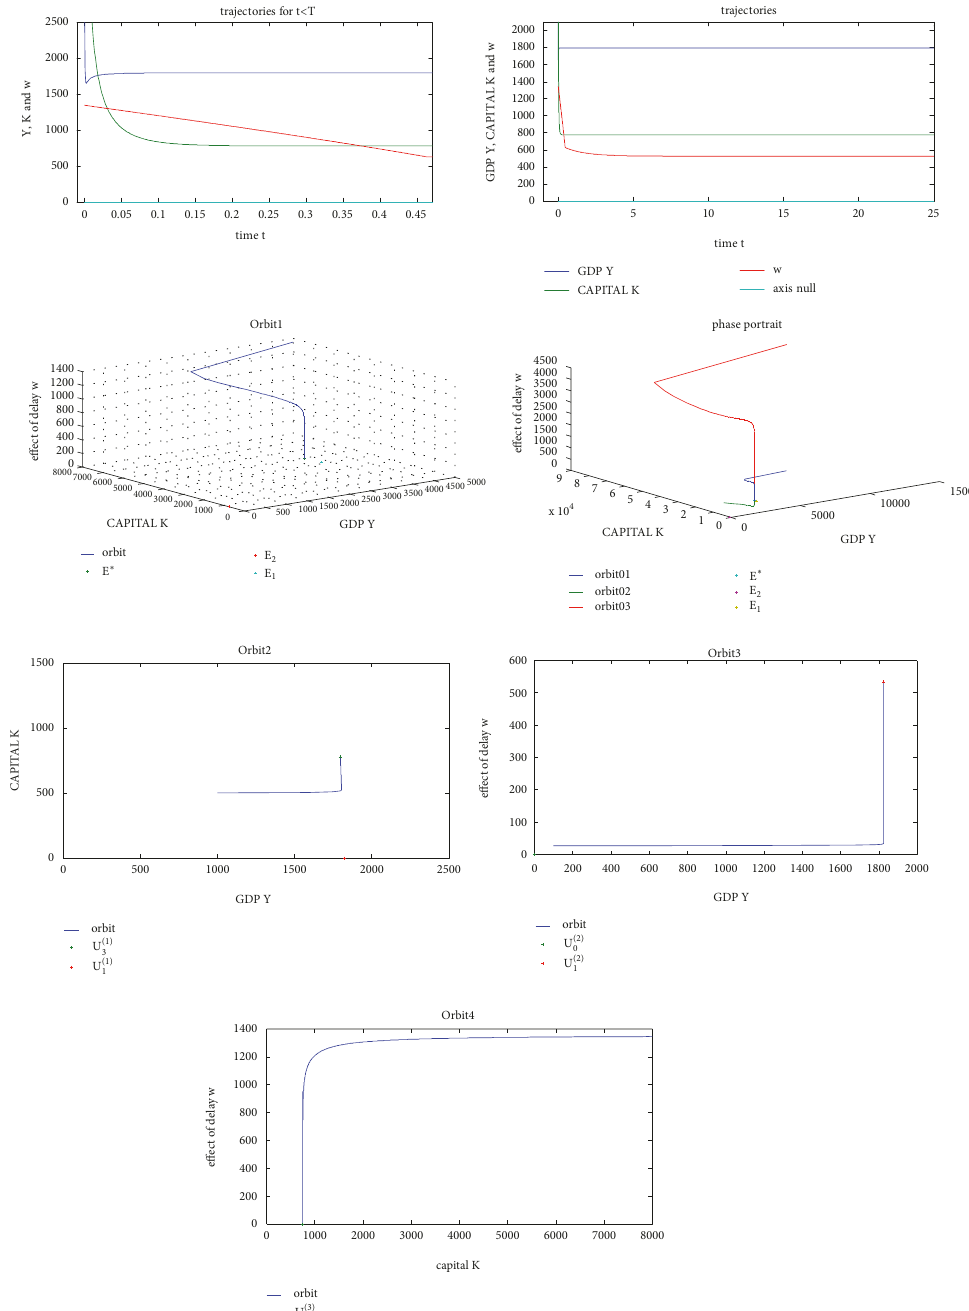
Figure 2: Trajectories, orbits, and phase portrait with 𝑢 0 (𝜃) = 𝜑(𝜃) = 𝑢(0)𝑒 𝐴𝜃 /(1 + 𝑢(0)(𝑒 𝐴𝜃 − 1)) , ∀𝜃[−𝑇;0] , where 𝐴 = (1/2𝑇) ln {|𝑢(0) − 1|/𝑢(0)} if 𝑢(0) ̸= 1 and 𝐴 = −1/2𝑇 if 𝑢(0) =